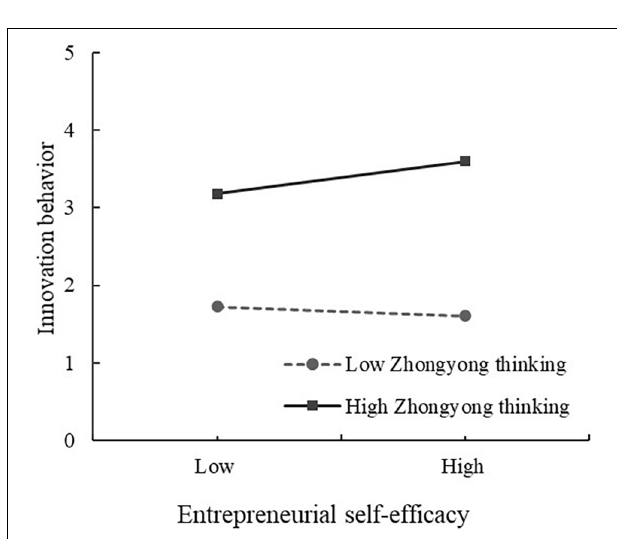
FIGURE 3 | Moderating role of Zhongyong thinking in the relationship between entrepreneurial self-efficacy and innovation